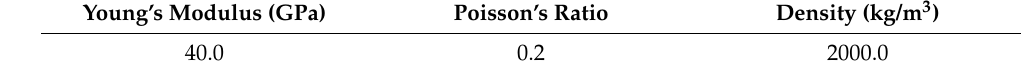
Table 1. Material properties of arches.